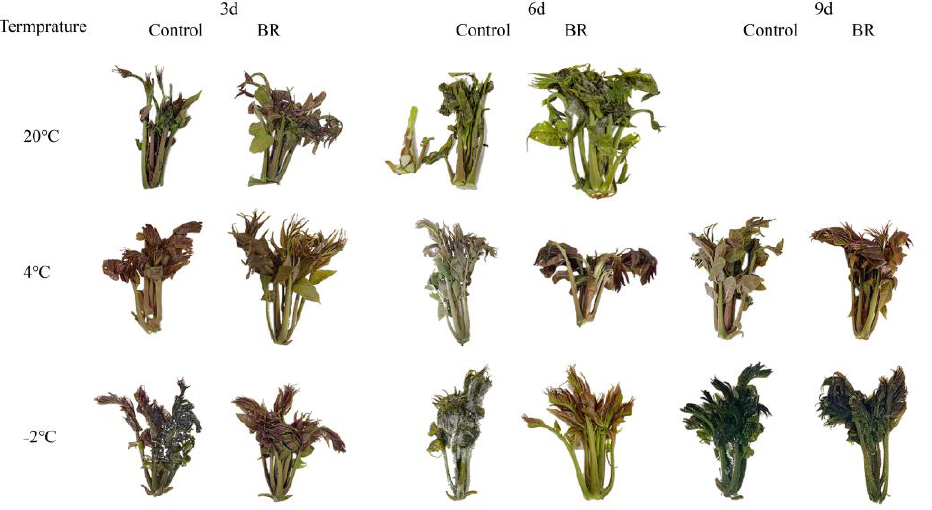
Figure 1. Appearance changes of T. sinensis as affected by BR treatment during different tempera- ture storage.